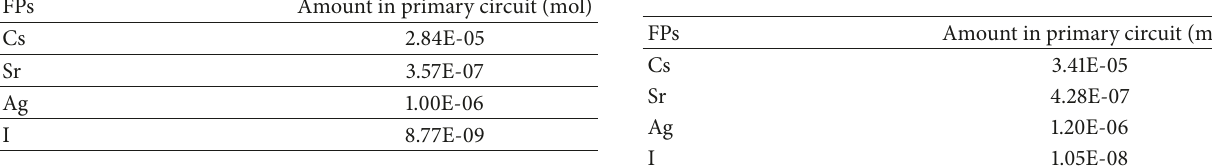
Table 7: Accumulation of Cs/Sr/Ag/I in the primary circuit. Table 8: Accumulation of Cs/Sr/Ag/I in the primary circuit 8 h after beginning of the